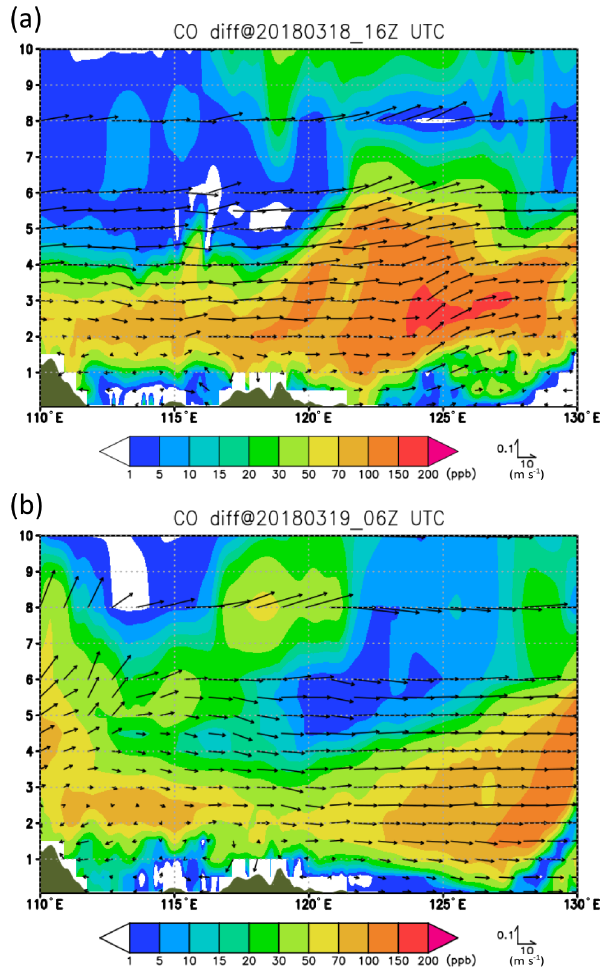
Figure 5. Simulated wind field (ms − 1 ) distribution and the con- centration (ppb) difference with and without BB emission for CO at cross section 30 ◦ N, (a) 16:00UTC, 18 March 2018 and (b) 06:00UTC, 19 March 2018. Wind vectors represent along- section winds, with scales shown at the down-right corner of plot (unit: ms − 1